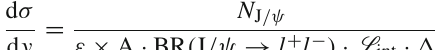
Table 3 Measured differential cross sections d σ/ d y for exclusive J /ψ photoproduction off protons in ultra-peripheral p–Pb (positive rapidity values) and Pb–p (negative rapidity values) collisions at TeVinthedifferentrapidityintervals.Valuesofthephotonflux k d n / d k , the interval in W γ p corresponding to the rapidity, the average W γ p